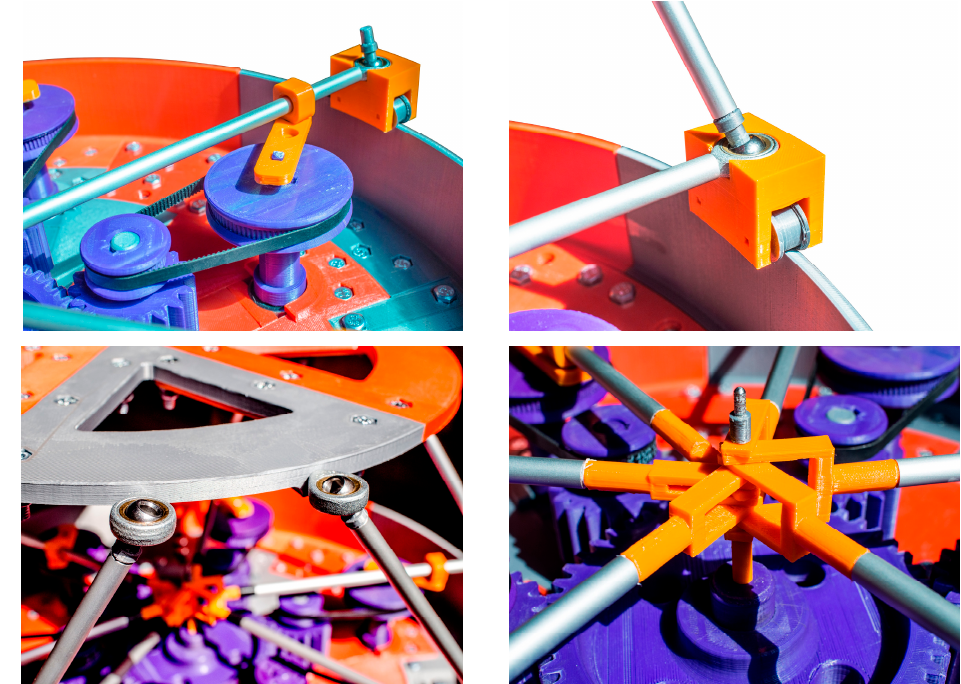
Figure 7. The main units of motion transmission of the proposed hexapod.